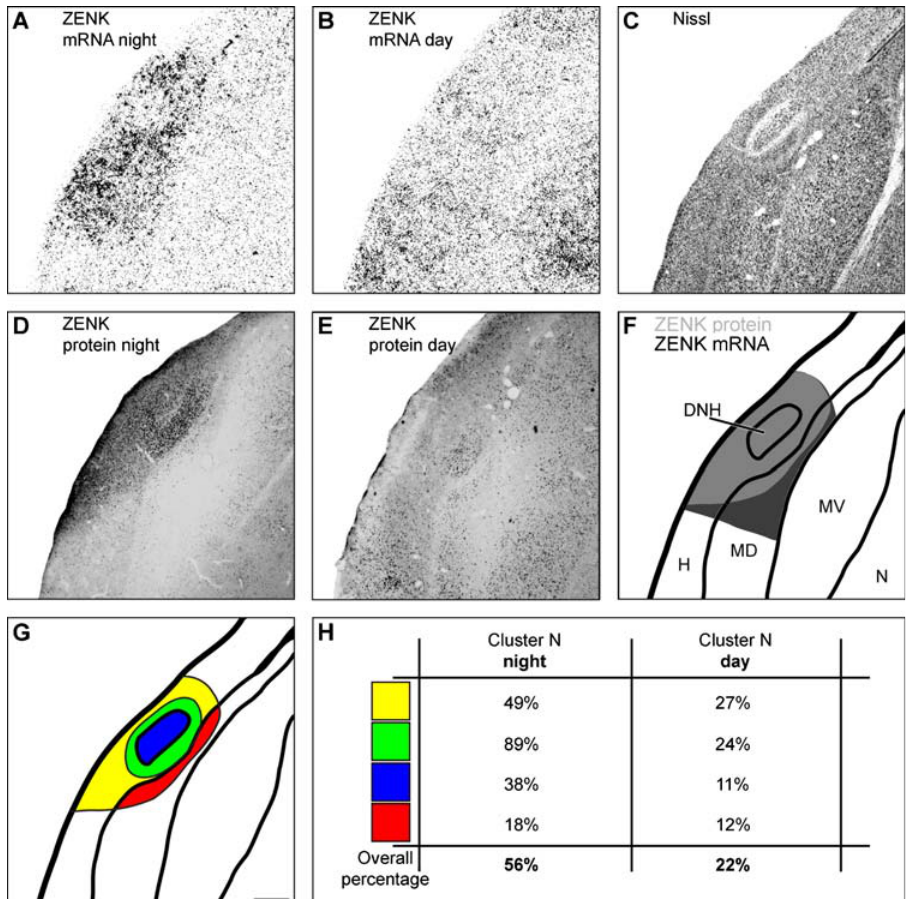
Figure 3. Detailed quantification of ZENK protein expression and comparison with ZENK mRNA expression within Cluster N. A: Expression of ZENK mRNA during night-time covers posterolateral parts of the hyperpallium and underlying mesopallium. In the DNH nucleus, the amount of ZENK mRNA transcripts is decreased. D: Expression of ZENK protein during night-time covers hyperpallial compartments comparable to the expression of ZENK mRNA but decreases in mesopallial portions. Within Cluster N, approximately 56% of neurons show nuclear expression of ZENK protein with highest relative amounts of ZENK-positive nuclei found in the shell surrounding the DNH nucleus. B: Decreased expression of ZENK mRNA and E: protein during day in the whole hyperpallium. Nuclear ZENK protein is found in approximately 22% of Cluster N neurons. Note that, ventral mesopallial (MV) and nidopallial (N) portions show increased ZENK expression on the mRNA and protein level compared to night-time activation patterns. C: Corresponding Nissl-stained section and F: schematic drawing display morphological features and neuroanatomical location of Cluster N within the telencephalon. G: Determination of four subregions within Cluster N defined by morphological boundaries (compare Fig. 3C): DNH nucleus (Fig. 3G, shown in blue); the shell surrounding DNH nucleus (Fig. 3G, shown in green); the remaining hyperpallial Cluster N part (Fig. 3G, shown in yellow); the mesopallial Cluster N part (Fig. 3G, shown in red). Scale bar (for A–G): 250 m m. H: Quantification of percentages of neurons with nuclear expression of ZENK within each subunit. Abbreviations: DNH, dorsal nucleus of the hyperpallium; H, hyperpallium, MD, dorsal mesopallium; MV, ventral hyperpallium; N, nidopallium.